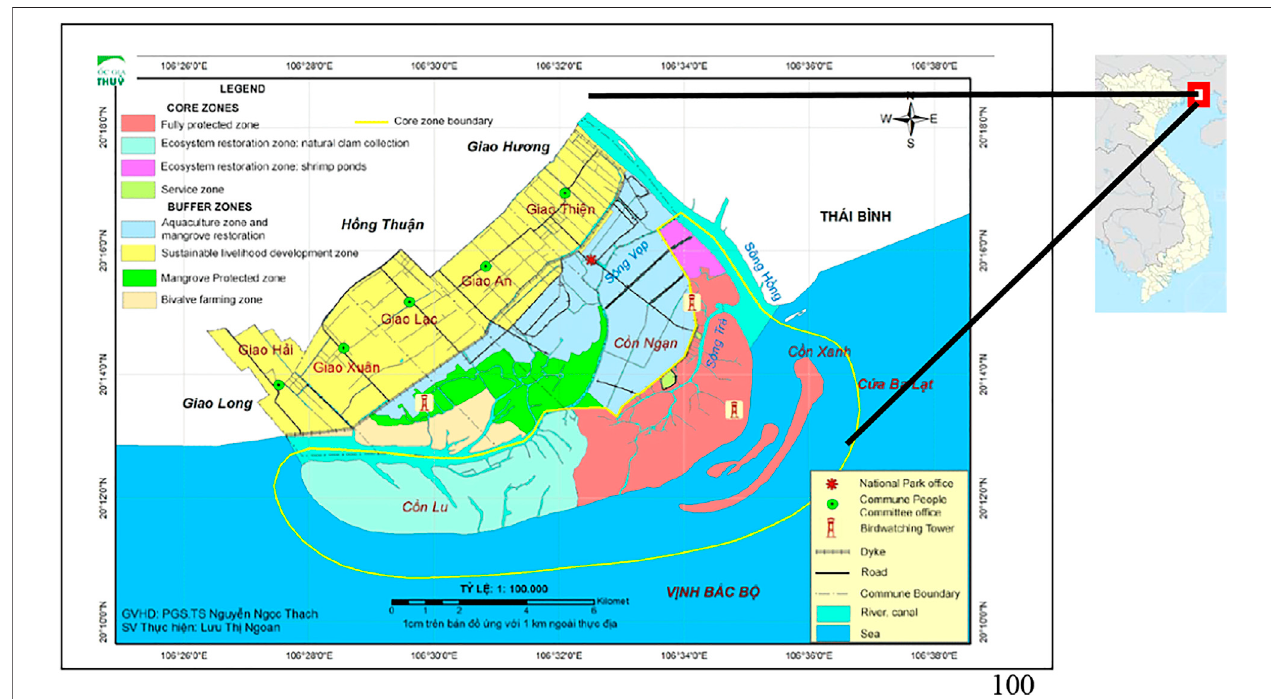
FIGURE 1 | Map of the study